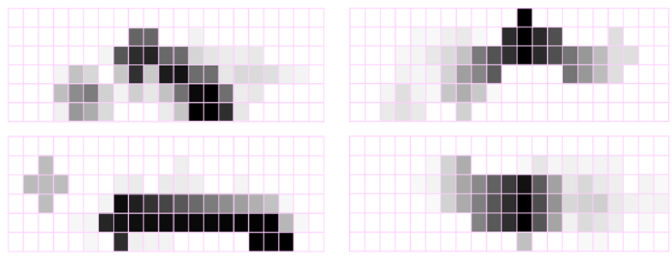
Figure 10. Trimmed protrusion